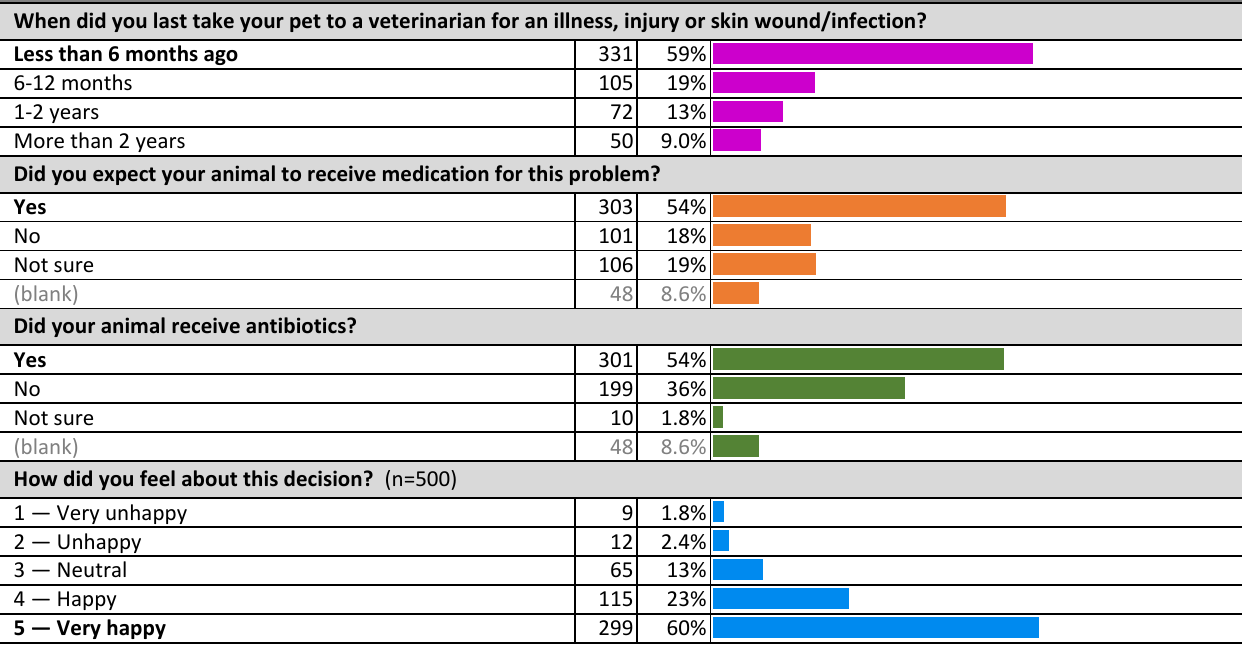
expected medication (89% positive) (Figure